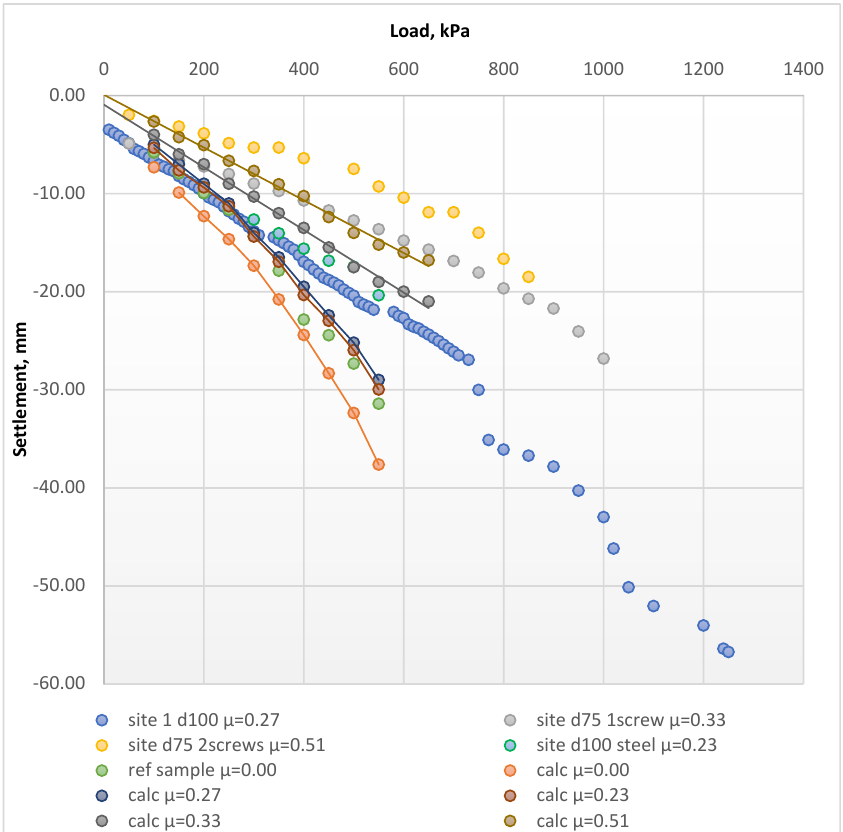
Figure 13. The load – settlement curve for each tested in situ sample compared to the theoretical Figure 13. The load–settlement curve for each tested in situ sample compared to the theoretical calculation results. Calculated results are specified with the term “ calc ”. Site test results are speci- calculation results. Calculated results are specified with the term “calc”. Site test results are specified fied with the term “ site ”. Reference samples without reinforcement correspond to “ ref sample µ = with the term “site”. Reference samples without reinforcement correspond to “ref sample µ = 0.00 ”.